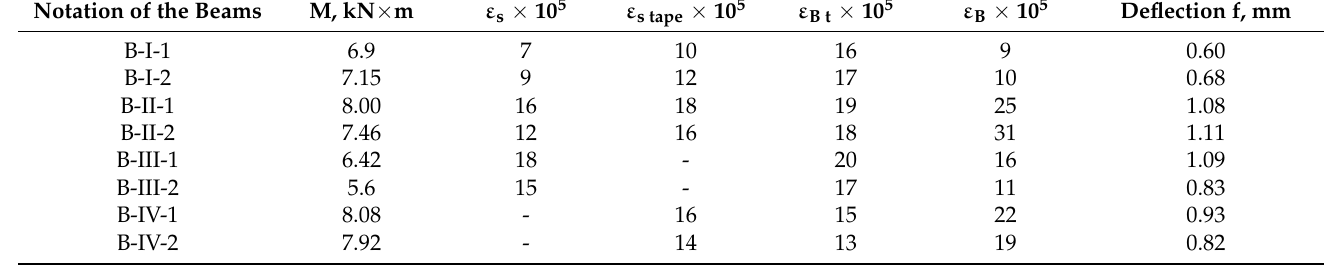
Table 3. Experimental results of the moments of crack formation in the zone of maximum bending moment.